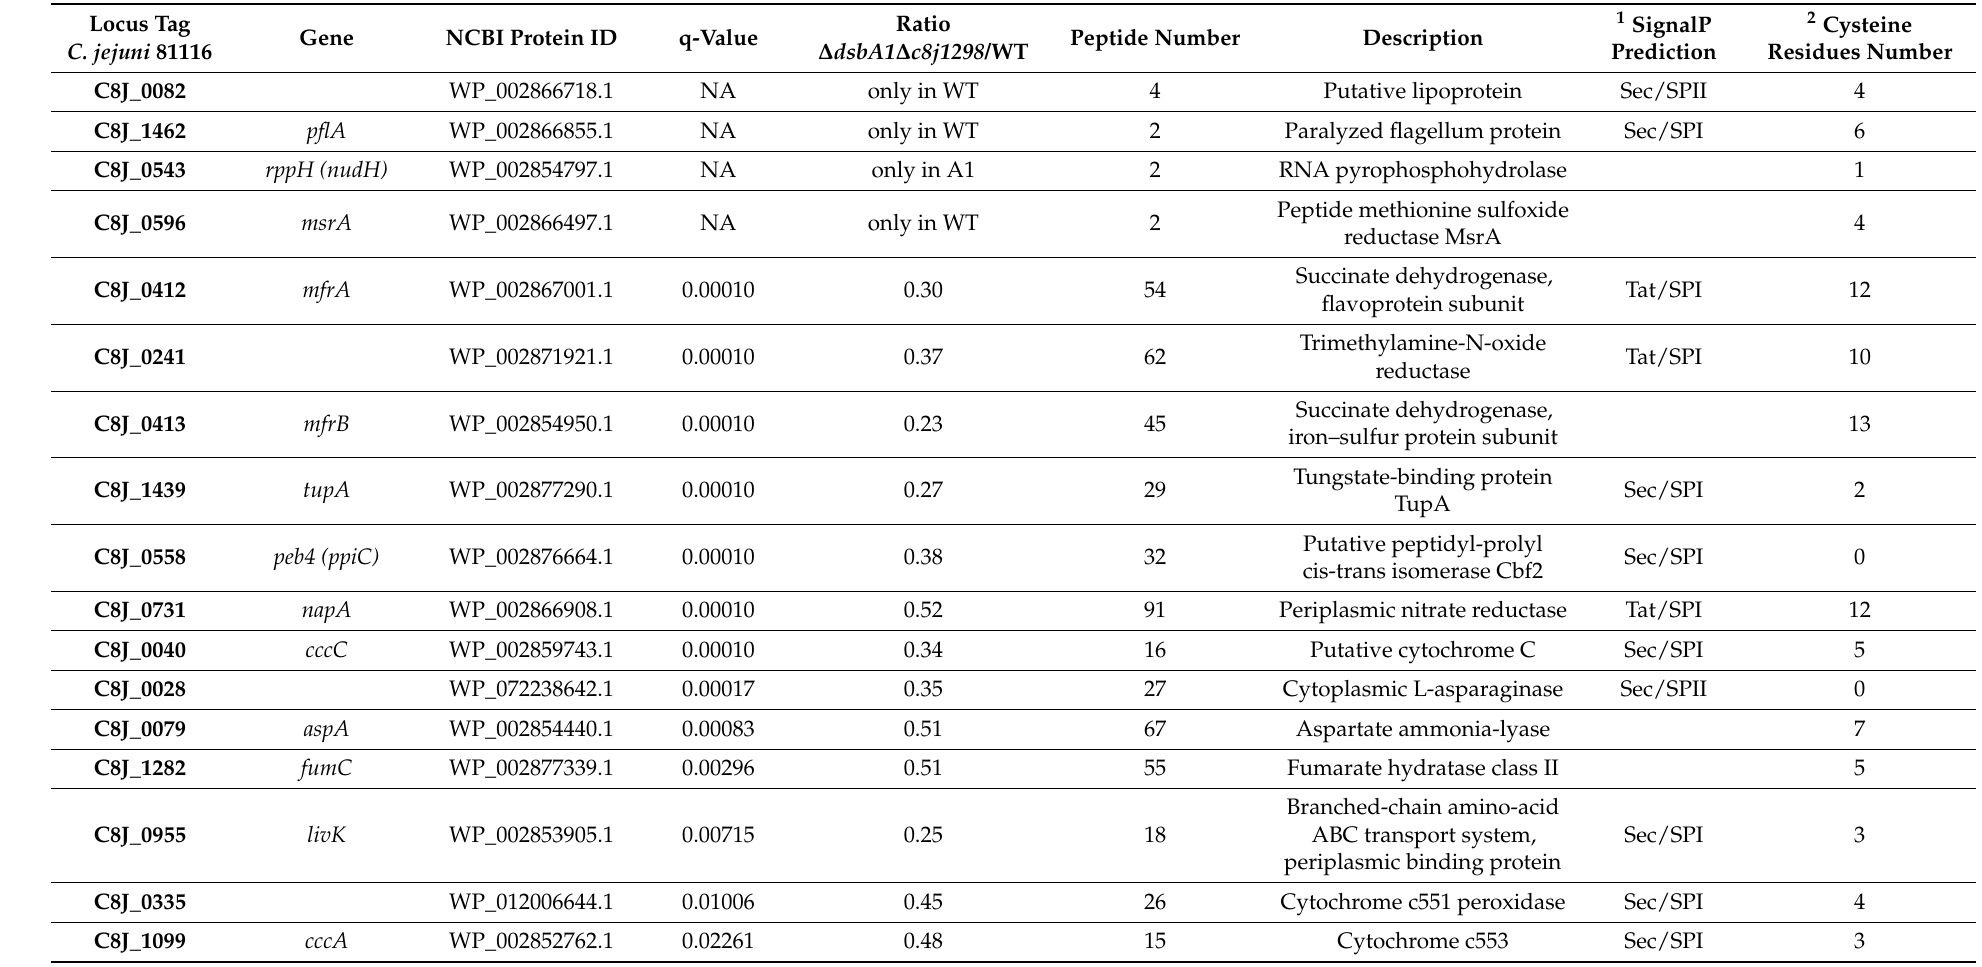
Table 4. Proteins whose ratio was 0.55 or less in ∆ dsbA1 ∆ c8j_1298 comparing to C. jejuni 81116 wild-type strain ( p <